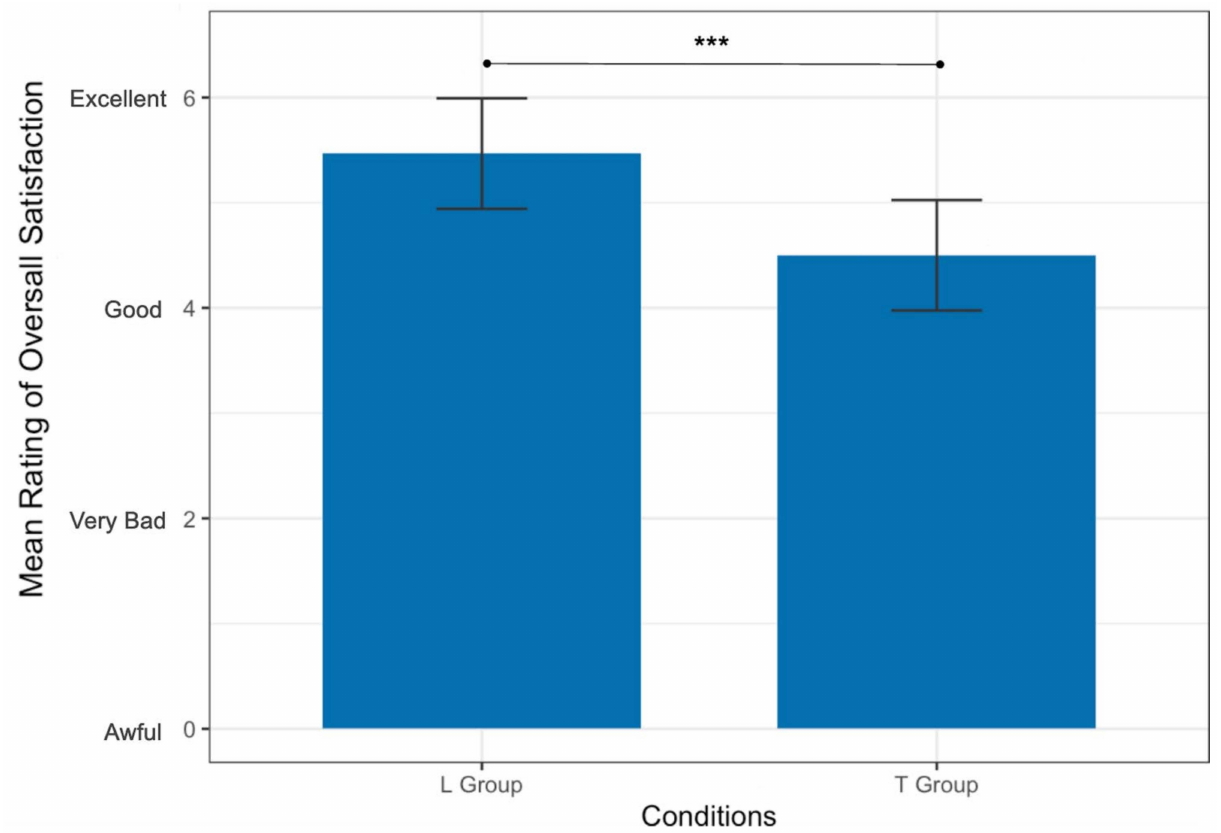
Figure 6. Illustrating the mean ratings of overall satisfaction with associated standard deviation for both groups (L and T), where 0 represents awful and 6 represents excellent. Abbreviations: T Group: 20% benzocaine topical gel + placebo laser; L Group: photobiomodulation + placebo gel. [***] repre- sents significance at the p < 0.001